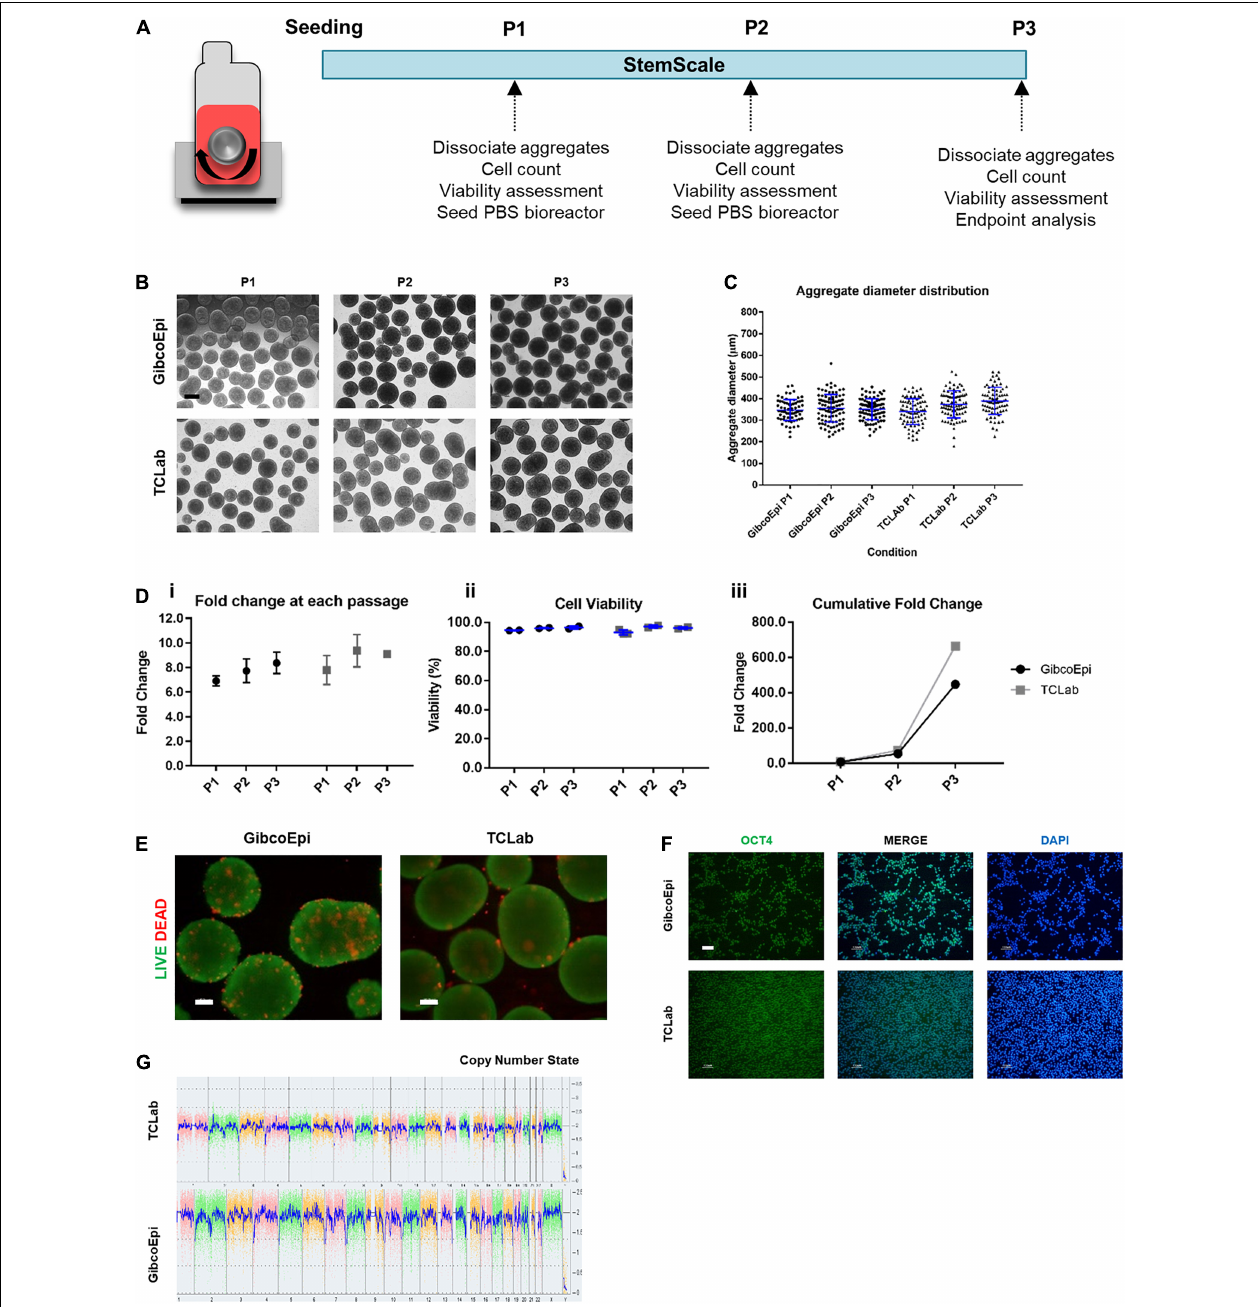
FIGURE 2 | Expansion of hiPSCs under agitated conditions using vertical-wheel bioreactors. (A) Schematic overview of hiPSC expansion on vertical-wheel bioreactor using StemScale. (B) Bright Field images of 3D aggregates before P1, P2, and P3 for GibcoEpi and TCLab cells lines. Scale bars: 100 µ m. (C) Distribution of hiPSC aggregate diameters obtained using StemScale before P1, P2, and P3. (D) Fold change (i) , cell viability (ii) and cumulative fold change (iii) of hiPSC at P1, P2, and P3. (E) Viability of cells in 3D aggregates at P3, using LIVE/DEAD staining kit. Green: calcein-AM; Red: Ethidium homodimer-1. Scale bars: 100 µ m. (F) Immunocytochemical analysis of hiPSC obtained after three passages on vertical-wheel bioreactor and 48 h days after replating in Matrigel-coated plates for Oct4 expression. Nuclei were stained with DAPI. Scale bars: 100 µ m. (G) At the end of three passages, the karyotypic analysis remained normal.